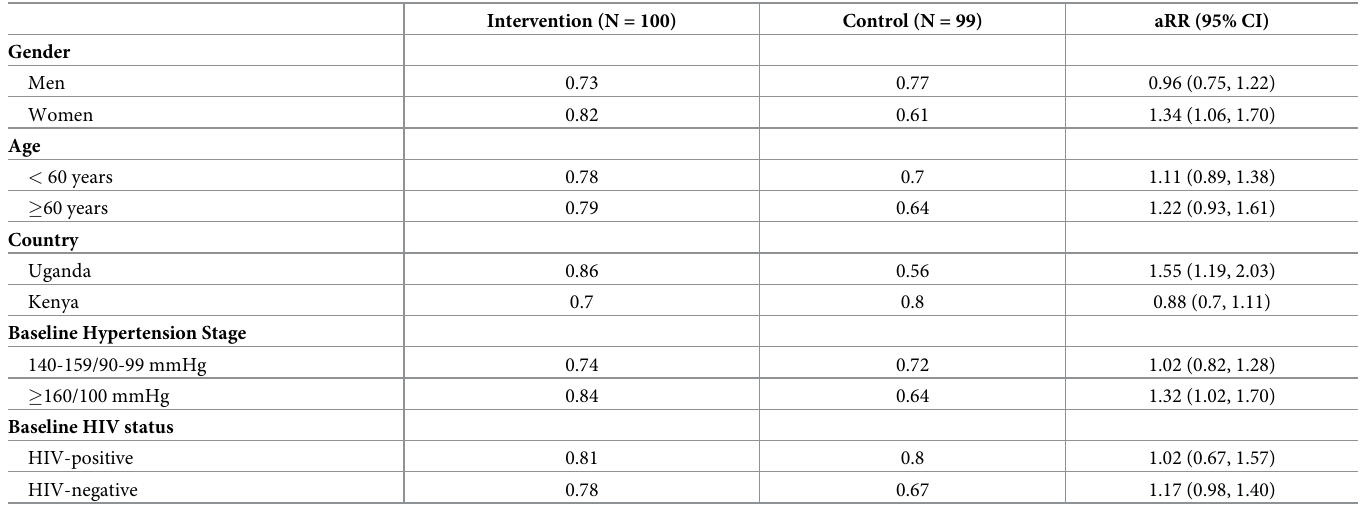
Table 5. Retention in care at 3 months, stratified by baseline participant